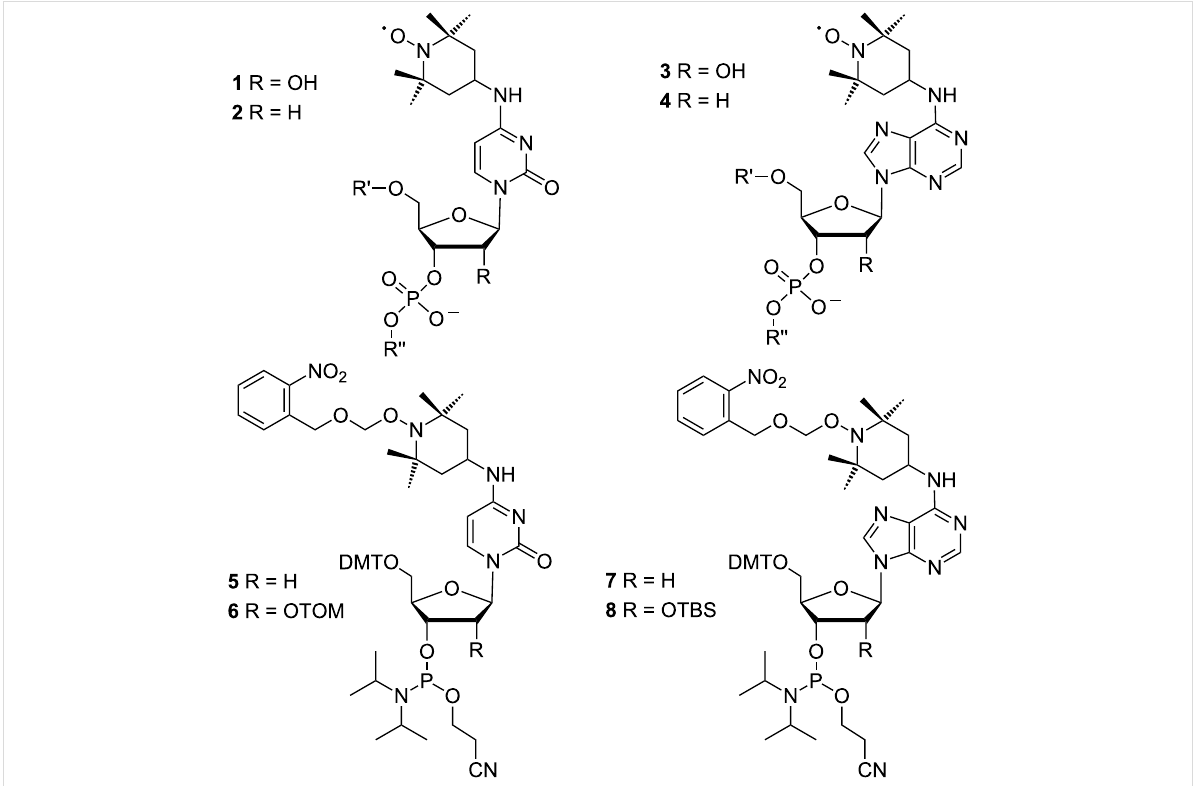
Figure 1: Structures of TEMPO-labeled oligonucleotides and of phosphoramidites 5 – 8 .